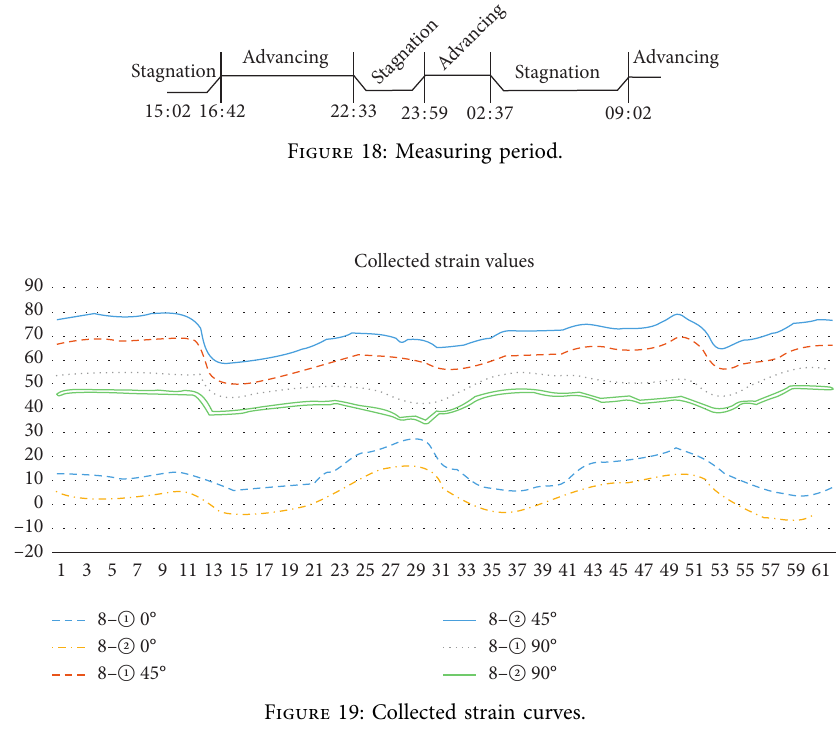
Figure 19: Collected strain curves.